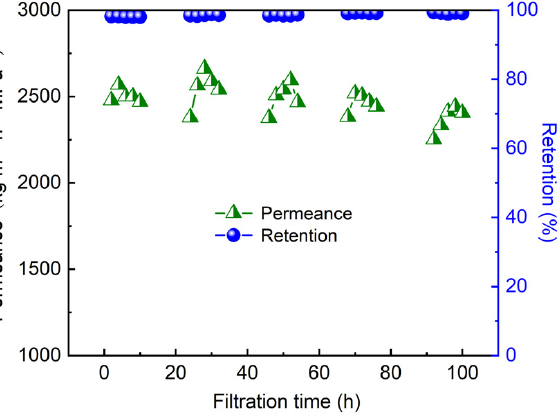
Figure 10. Effect of HA concentration on the separation performance of the CNTs/LDH membrane (preparation conditions: 0.1 g/L LDH, 2 wt.% CNT; operating pressure: 0.1 MPa).